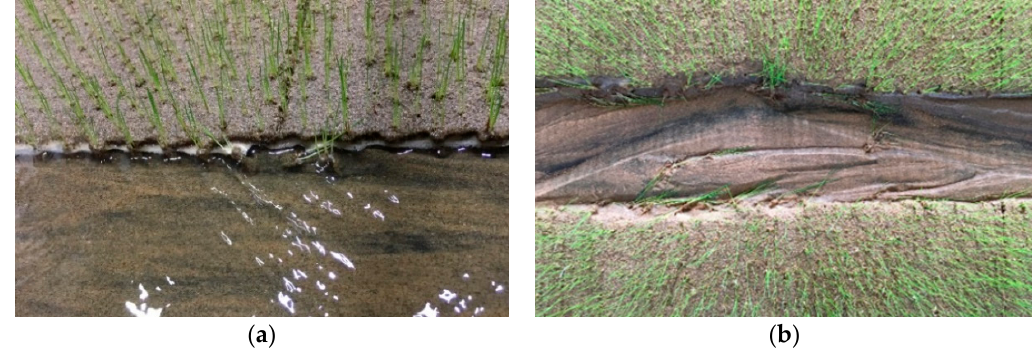
Figure 4. ( a ) Water washes the river bank-covering vegetation. ( b ) Vegetation revetment during channel evolution. channel